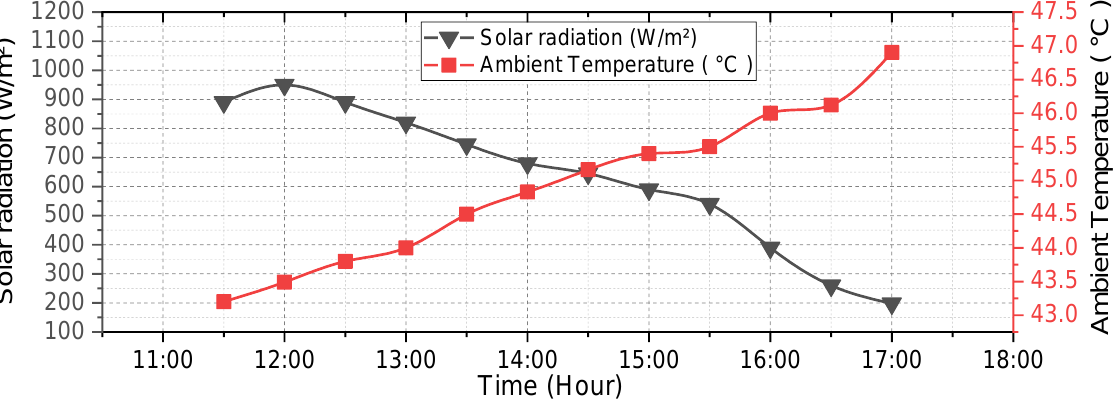
Figure 7. Solar radiation and ambient temperature for the L-TEG and NL-TEG during the day of the experiment.